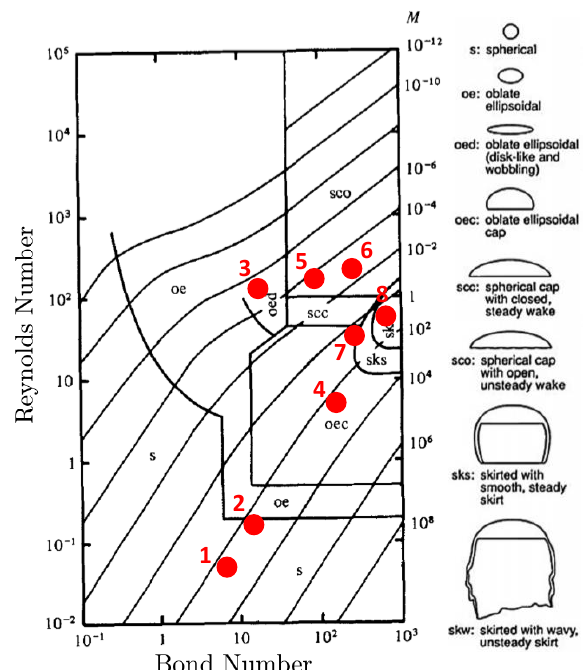
Figure 4. Bubble rising characteristic map based on the dimensionless numbers: Reynolds, Bond, and Morton numbers. The corresponding bubble shapes are depicted to the right. The red dots reference the simulations performed in the terminal velocity and shape verification study. This characterization map is reproduced with permission from Bhaga and Weber, 1981